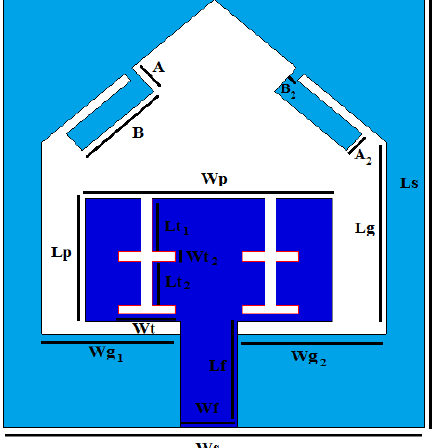
Fig. 4 illuminates the width effects Wt of the T-shaped slot dimensions. As illustrated, the eliminated band is shifted from 5 to 4 GHz when Wt increase from 2 to 3.5mm.